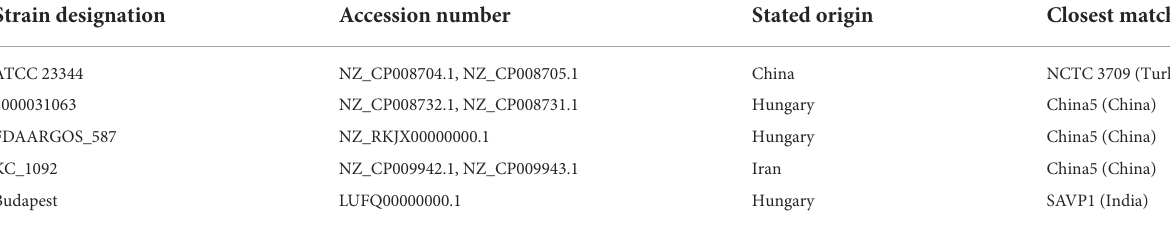
TABLE 4 Strains with incorrect metadata deposited in public repositories